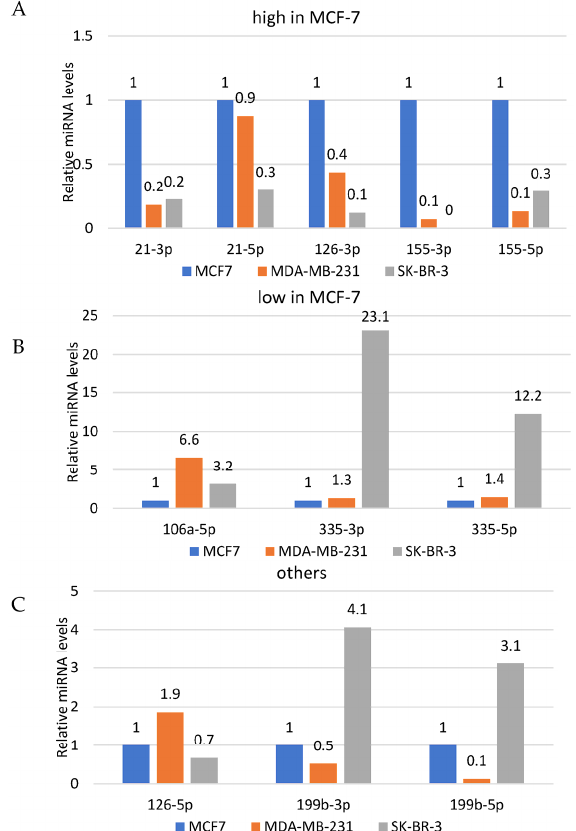
Figure 2. Quantitative assessment of the basal levels of selected miRNAs using qPCR in studied cell lines. miRNAs expression levels were grouped according to their pattern of expression for better representation. The data for all three cell lines (i.e., ( A ), MCF7; ( B ), MDA-MB-231; ( C ), SK-Br-3) were divided into three categories i.e., low, high and others, relative to MCF7 cells, selected as the refer- ence cell line (value “1”).